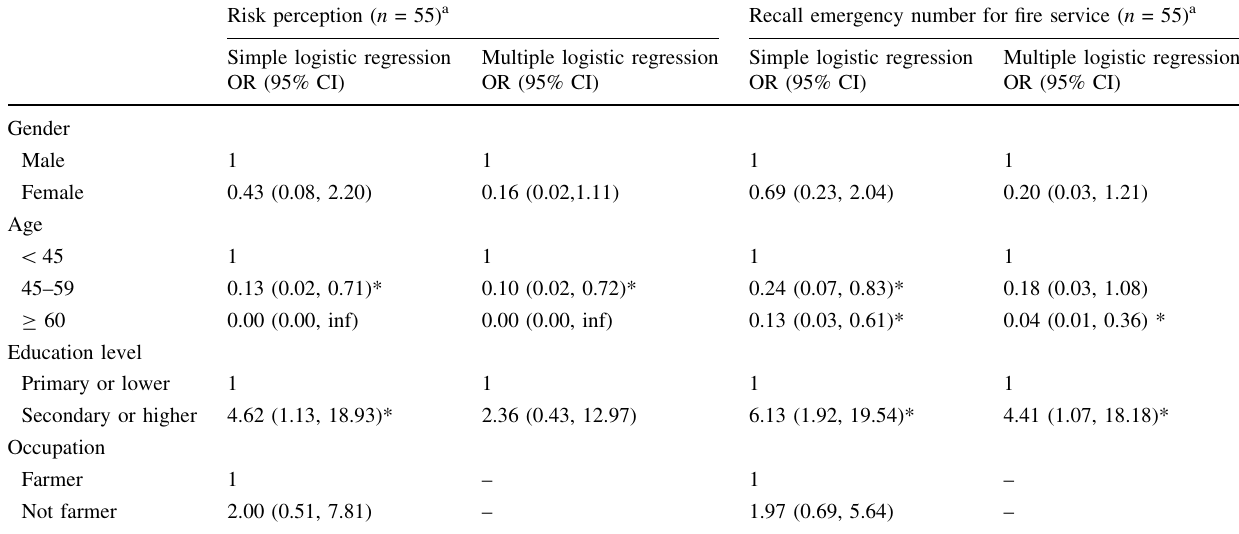
Table 3 Sociodemographic factors that associated with fire risk perceptions and fire response awareness before the 2015 general fire hazards health education intervention in Nanjiang Village, Guizhou Province,